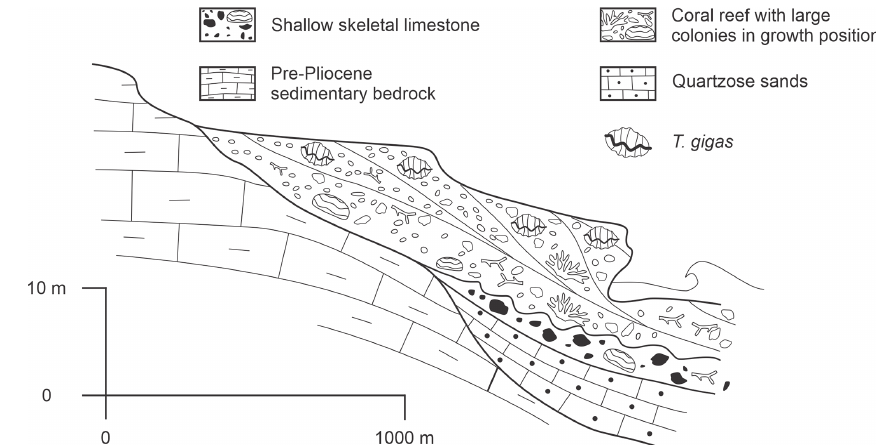
Figure 5. Litholog of emerged reef coast of Kenya (modified after Accordi et al.,